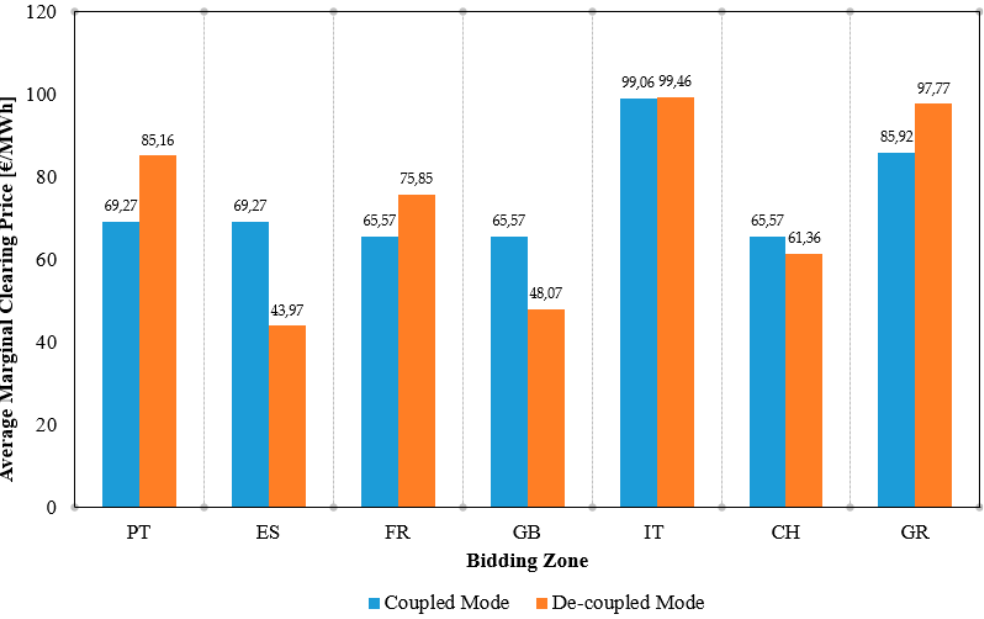
Figure 20. Comparison of average Marginal Clearing Prices (MCPs) for the coupled and de-coupled modes.